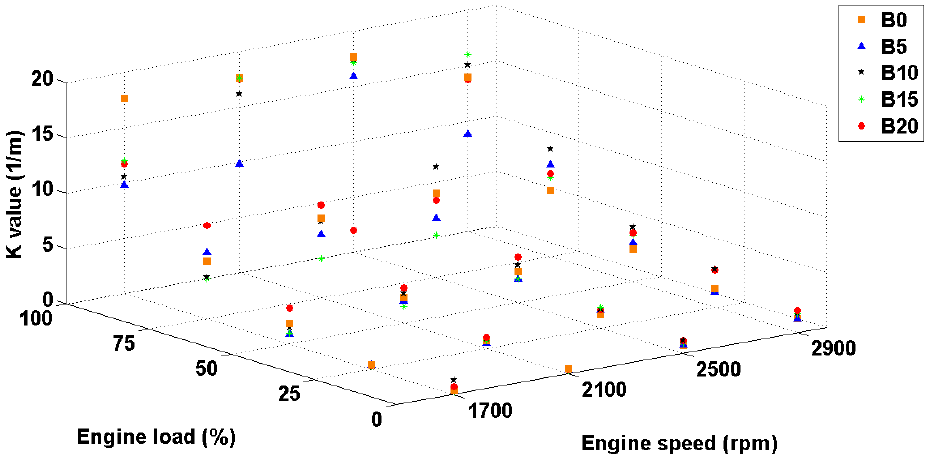
Figure 20. k values of the engine under different engine loads, speeds and biodiesel percentages.